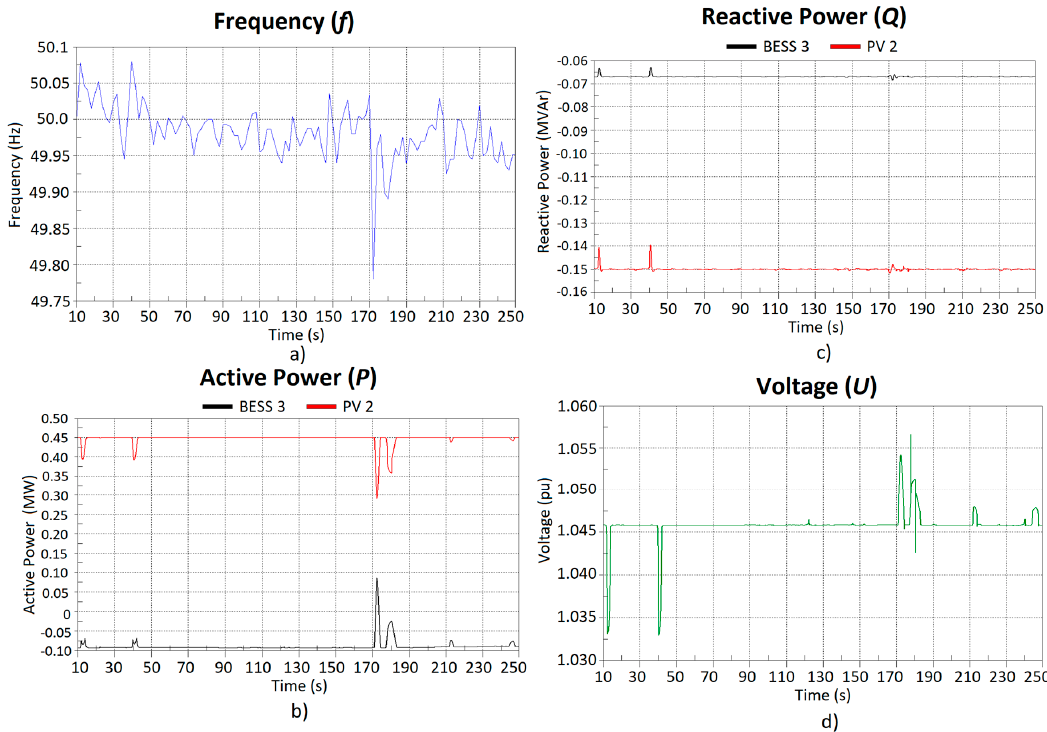
Figure 6. ( a ) Input frequency ( f ) data modified from real-life SSG measurements (Figure 5), PV 2 and BESS 3 ( b ) active ( P ) and ( c ) reactive power ( Q ), as well as ( d ) local voltage ( U ) behavior at PV 2 and